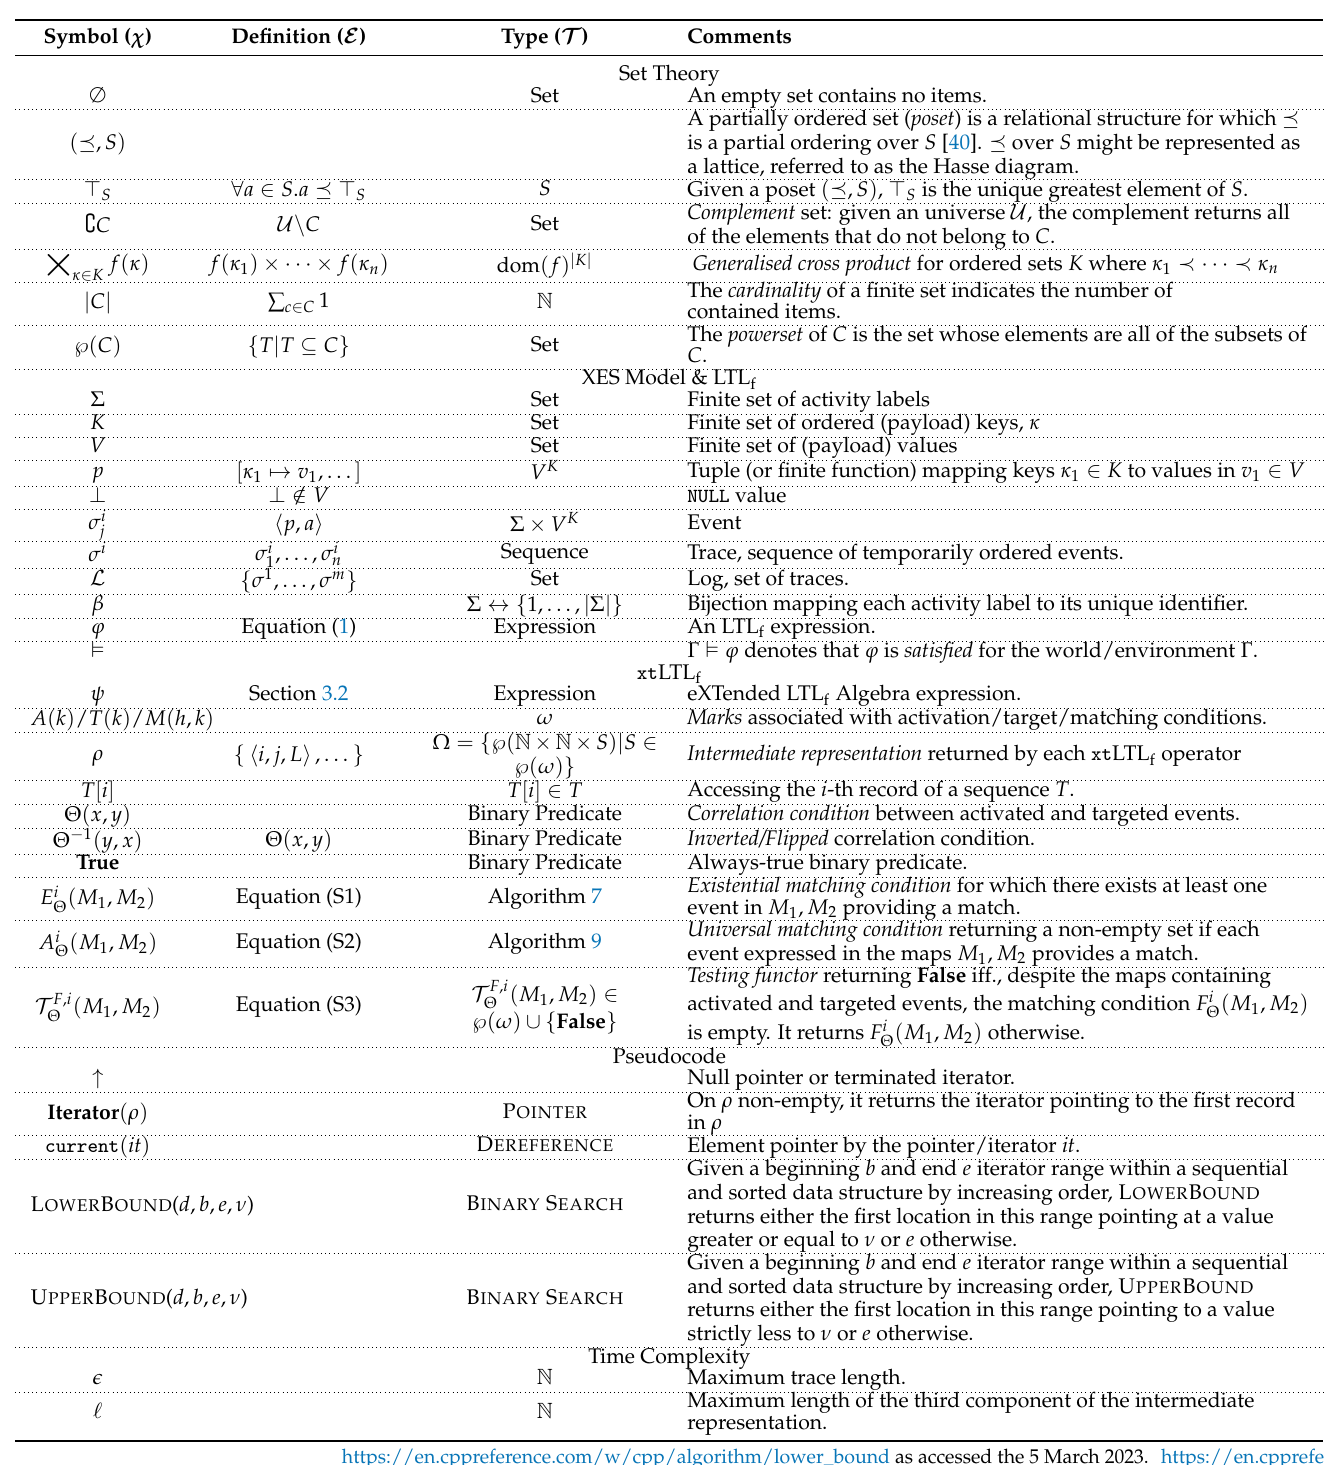
Table 4. Table of Notation for symbols χ ∈ T defined as ( χ : = E ) or characterised by ( E ( χ ) ) E